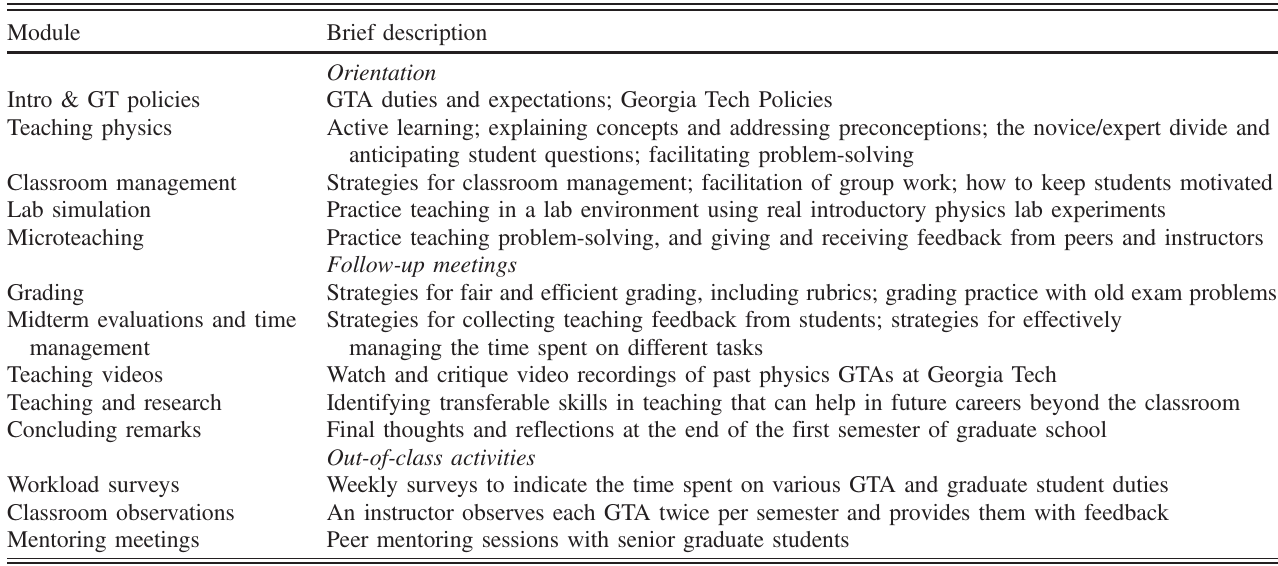
TABLE I. Physics GTA Preparation course structure (2019).